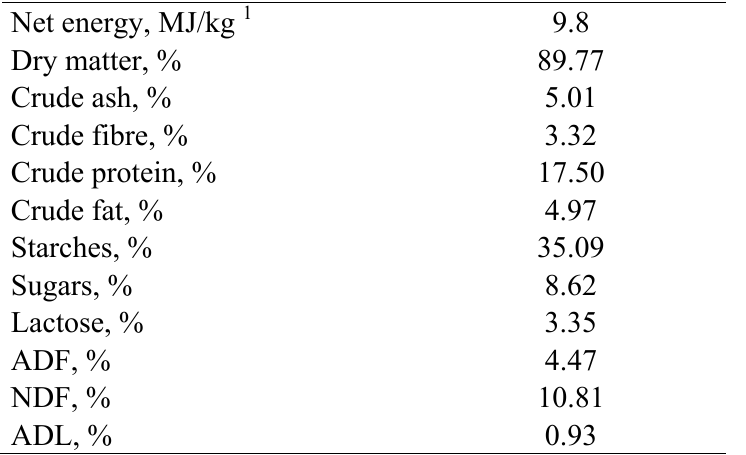
Table 2. Analyzed and calculated nutritional composition of the basal diet (as-fed basis) *